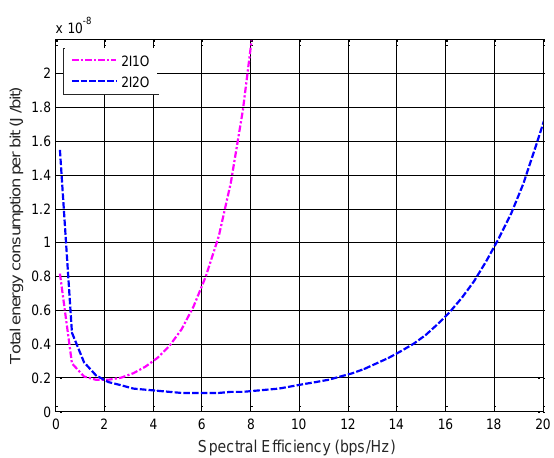
Figure 7 . Energy efficiency as a function of spectral efficiency in the adaptive WBAN system for two different MIMO configurations, d =